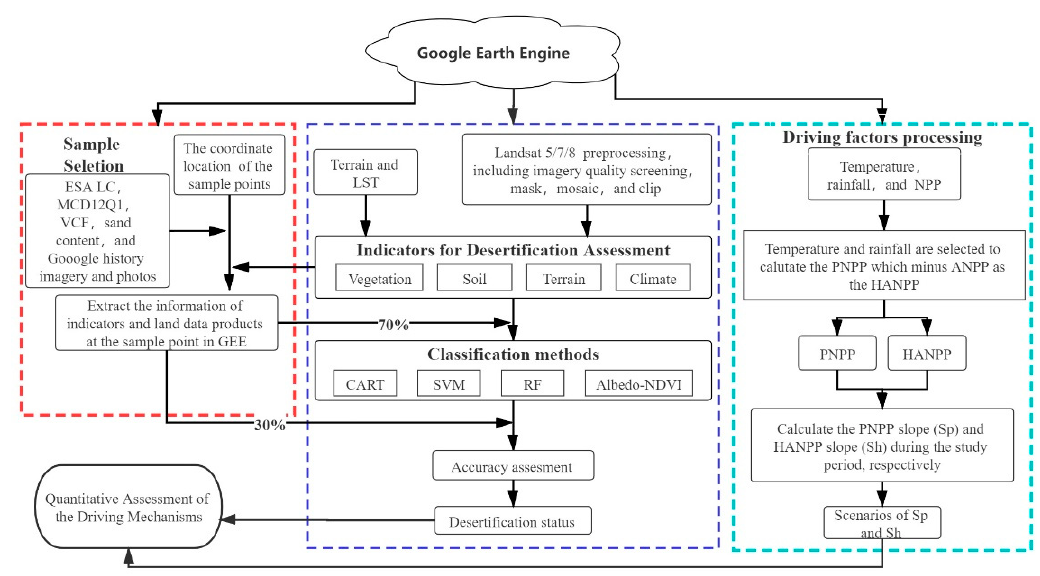
Figure 2. Flowchart of desertification assessment and mechanism analysis.